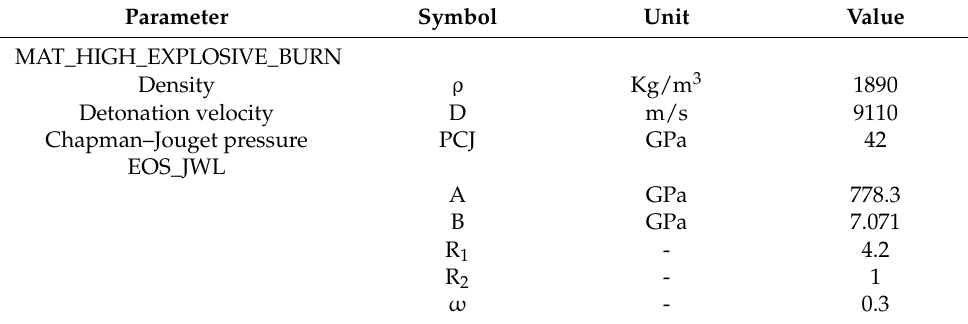
Table 2. Pressed octogen (HMX) explosive data with equation of state [23].